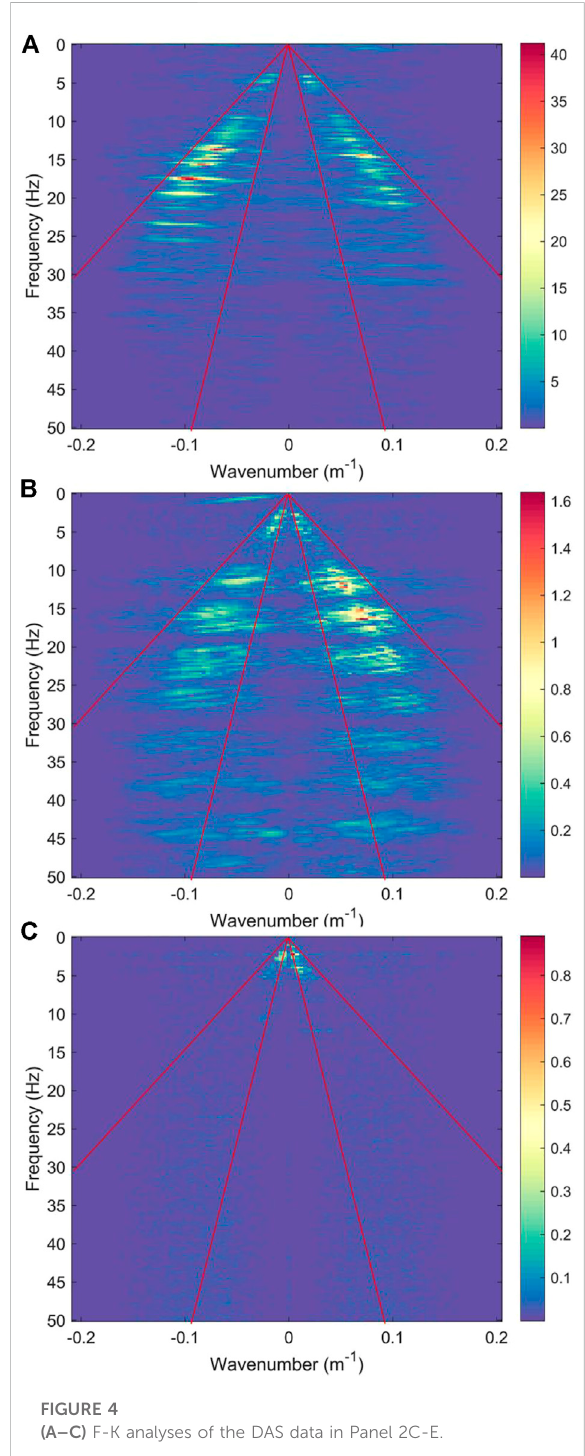
FIGURE 4 (A – C) F-K analyses of the DAS data in Panel